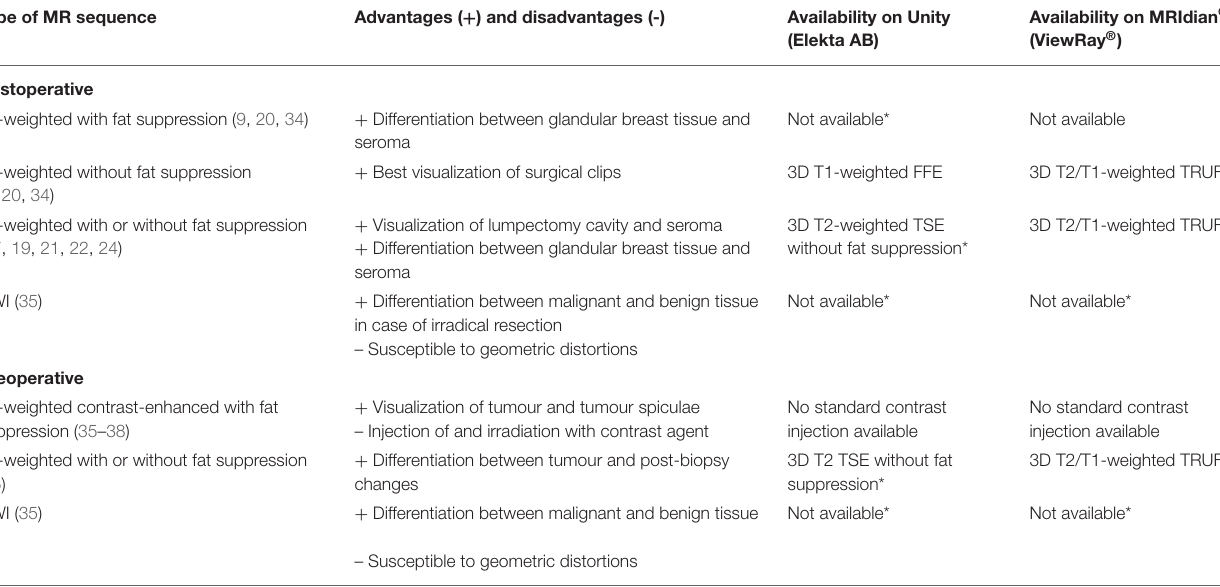
TABLE 2 | Overview of recommended MR sequences and commercial online availability for clinical breast cancer treatment on hybrid machines. Type of MR